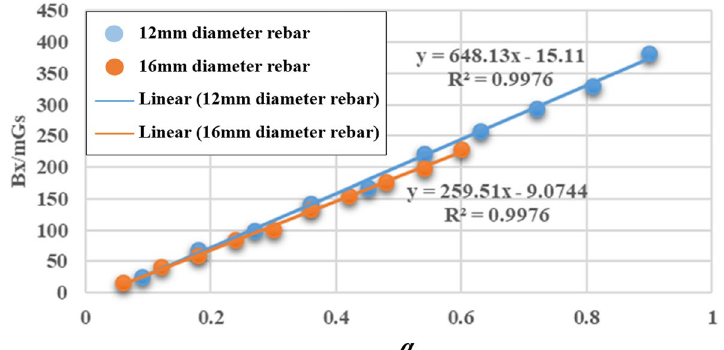
Fig. 16 Distribution of Bx extreme values of each model under different rust